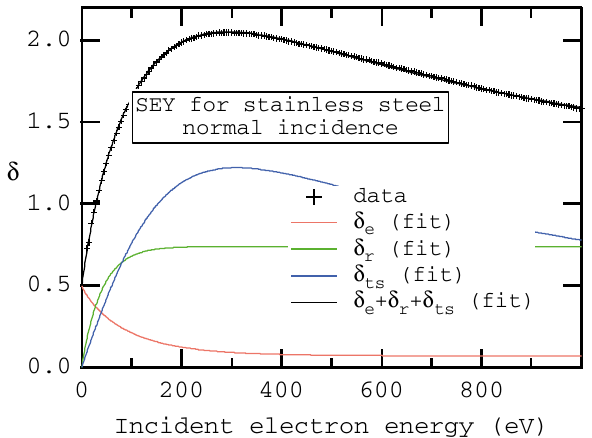
FIG. 1. (Color) The SEY for stainless steel for SLAC standard 304 rolled sheet, chemically etched and passivated but not conditioned. The parameters of the fit are listed in Table II. Data courtesy of R.